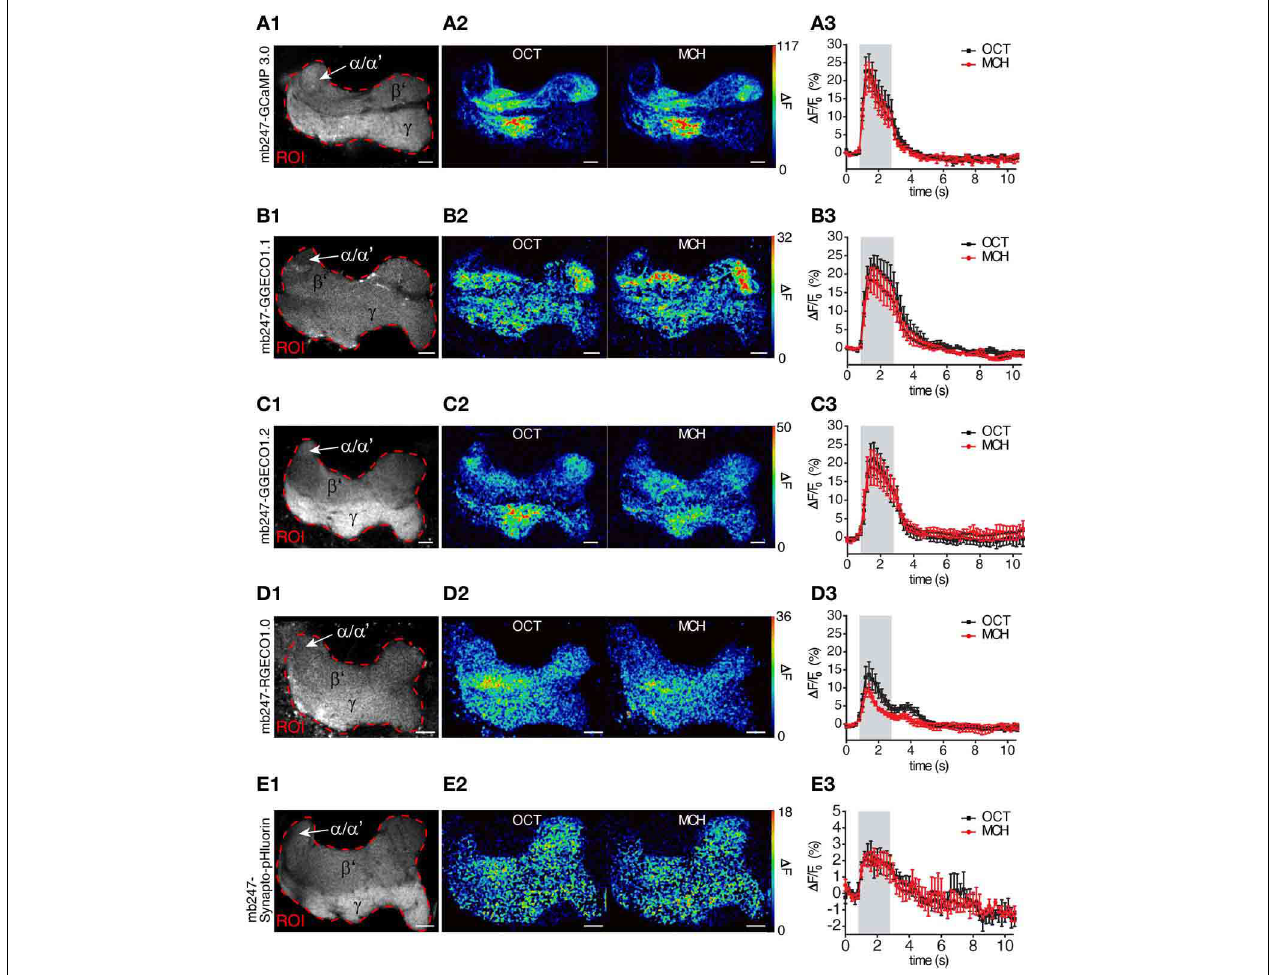
FIGURE 2 | Mb247-driven expression of fluorescent sensor proteins. Optical imaging of odor-evoked neuronal activity in Kenyon cells of the adult Drosophila mushroom body using different reporter proteins, i.e., (A1–A3) the Ca 2 + sensor GCaMP3.0, (B1–B3) the Ca 2 + sensor G-GECO1.1, (C1–C3) the Ca 2 + sensor G-GECO1.2, (D1–D3) Ca 2 + sensor R-GECO1.0, and (E1–E3) Synapto-pHluorin. The left row (A1–E1) illustrates the fluorescence protein expression in one focal plane covering the horizontal lobes of the mushroom body. The dashed red line indicates the region of interest (ROI) in which odor-evoked changes